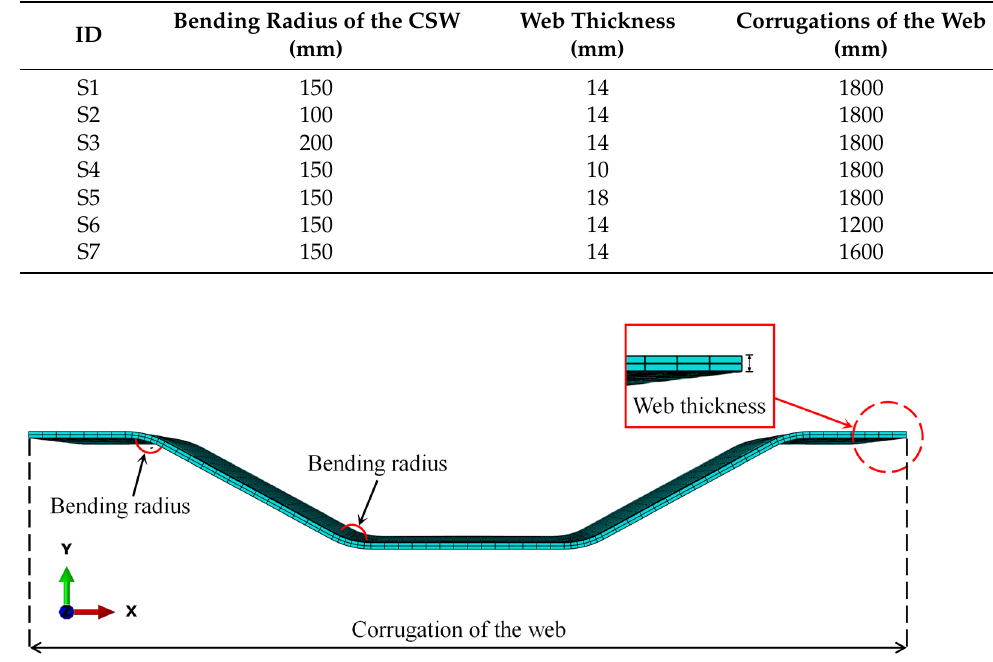
Table 2. Parametric details of the FE models.